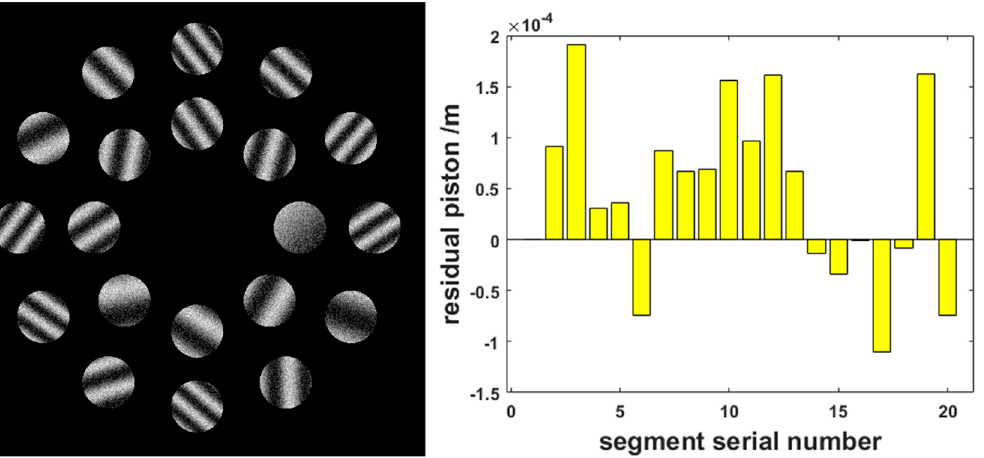
Figure 5. Simulation results with a random co-phasing error | ∆ p i | ≤ 1 mm, | ∆ tx i | ≤ 5 µ rad, | ∆ ty | ≤ 5 µ rad; the synthesis wavelength is 5170 µ m (642.8 and 642.88 nm, respectively),left is the interference fringe in 642.8 nm, and right is the residual between the real piston and measurement piston for all segmented mirrors.